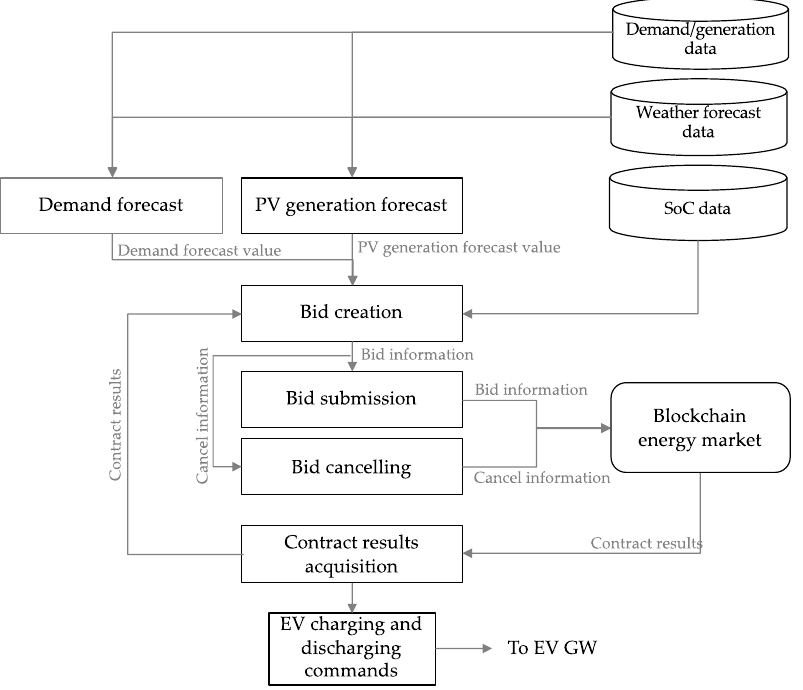
Figure 2. Calculation flow of user agent.